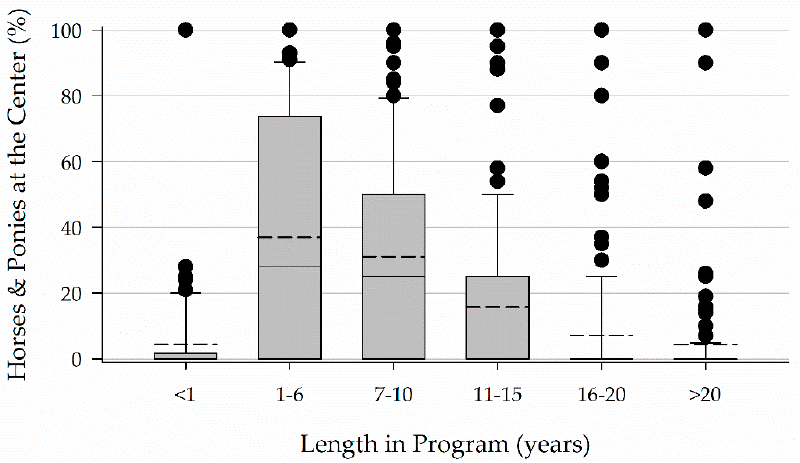
Figure 6. Length of time horses and ponies remain active in a program.